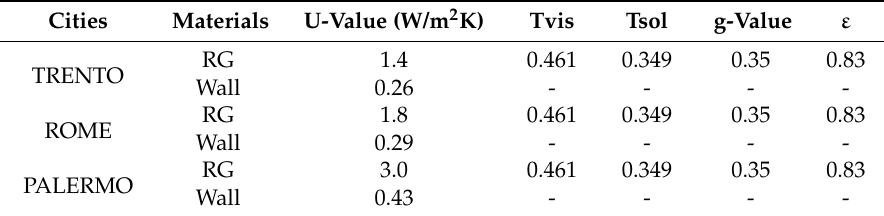
Table 4. Thermal and optical properties of the NZEB double glazing element.